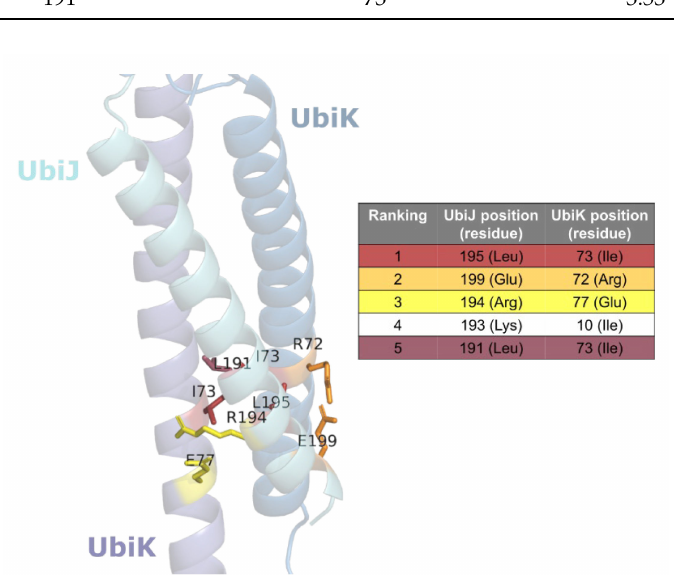
Figure 5. Co-evolution analysis. The top 5 best co-evolved residue pairs are listed in the table on the right and mapped onto the 3D structure of the heterotrimer on the